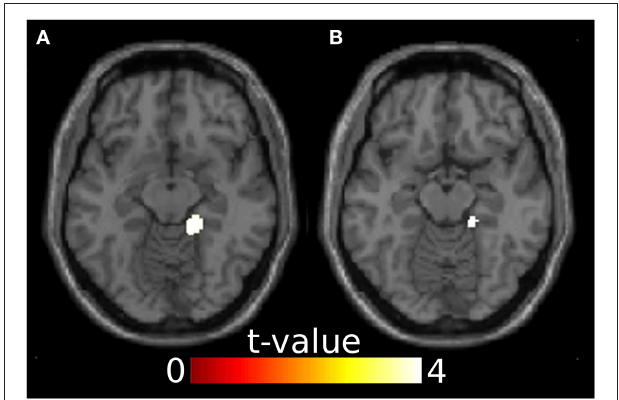
FIGURE 3 | Results from the source reconstruction analysis showing significant clusters in the right parahippocampal gyrus. (A) Incongruent > congruent, z = -12. (B) Anger incongruent > anger congruent, z = -14. Images are thresholded at p < 0.05 family-wise error